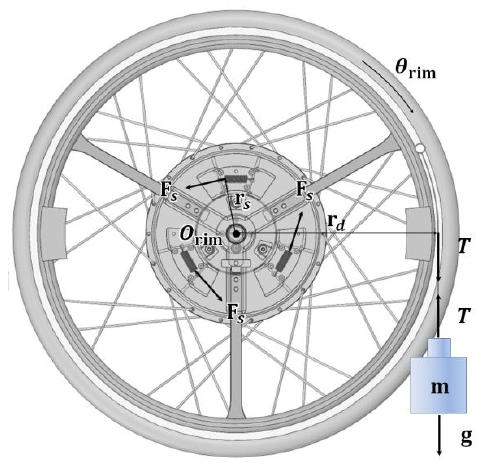
Figure 2. Free body diagram for driving torque measurement of the new designed wheel.